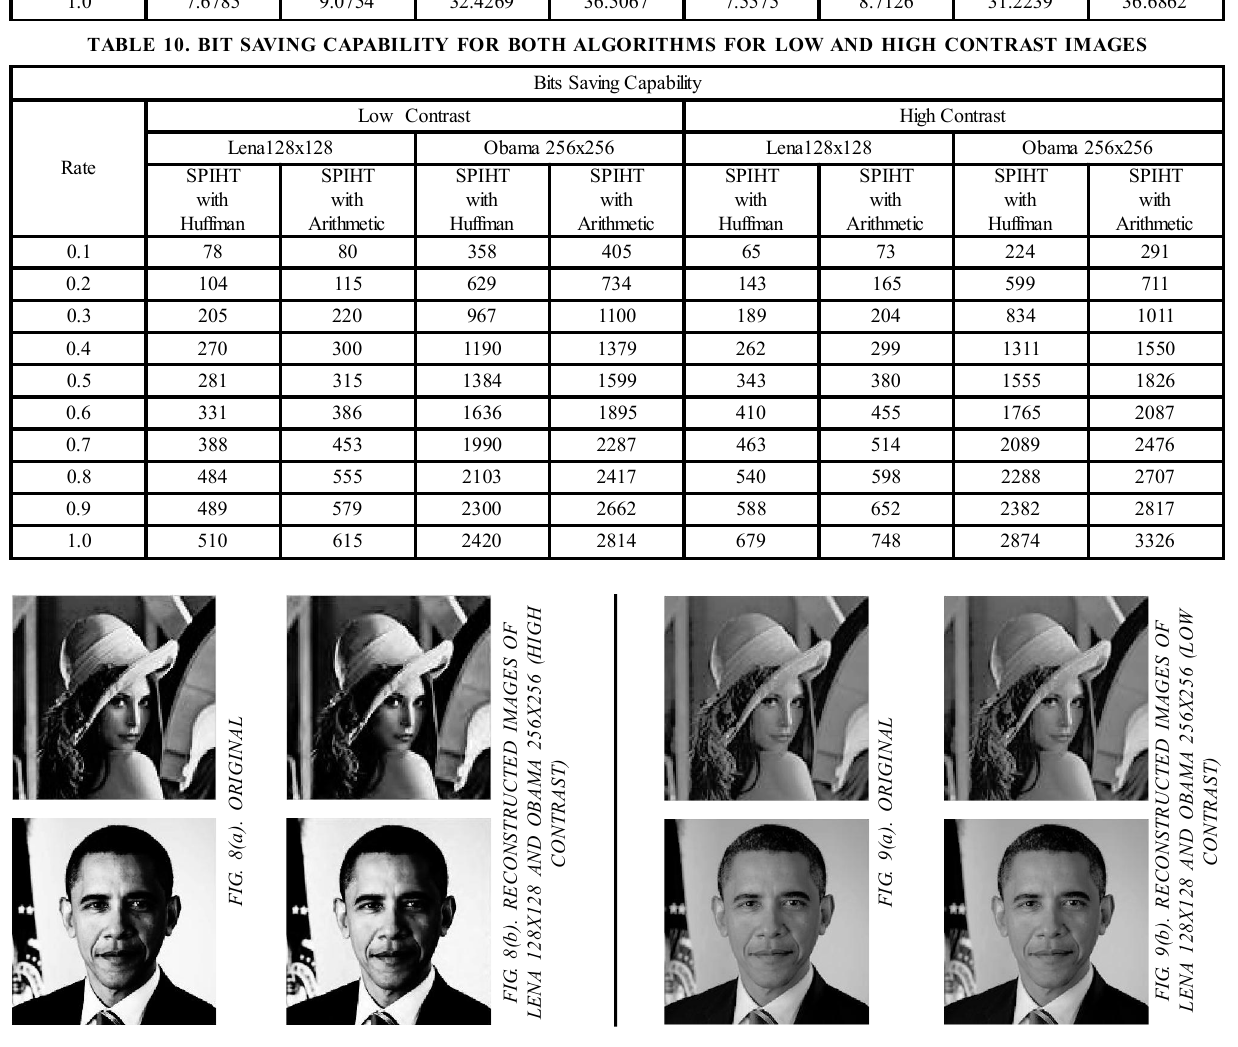
TABLE 10. BIT SAVING CAPABILITY FOR BOTH ALGORITHMS FOR LOW AND HIGH CONTRAST